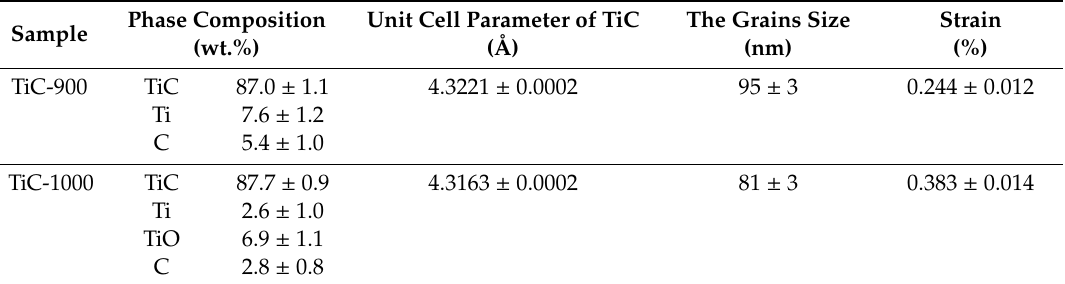
Table 1. Concentrations of the components and parameters of TiC estimated from full-profile Rietveld analysis of X-ray di ff raction data for TiC-900 and TiC-1000 samples.